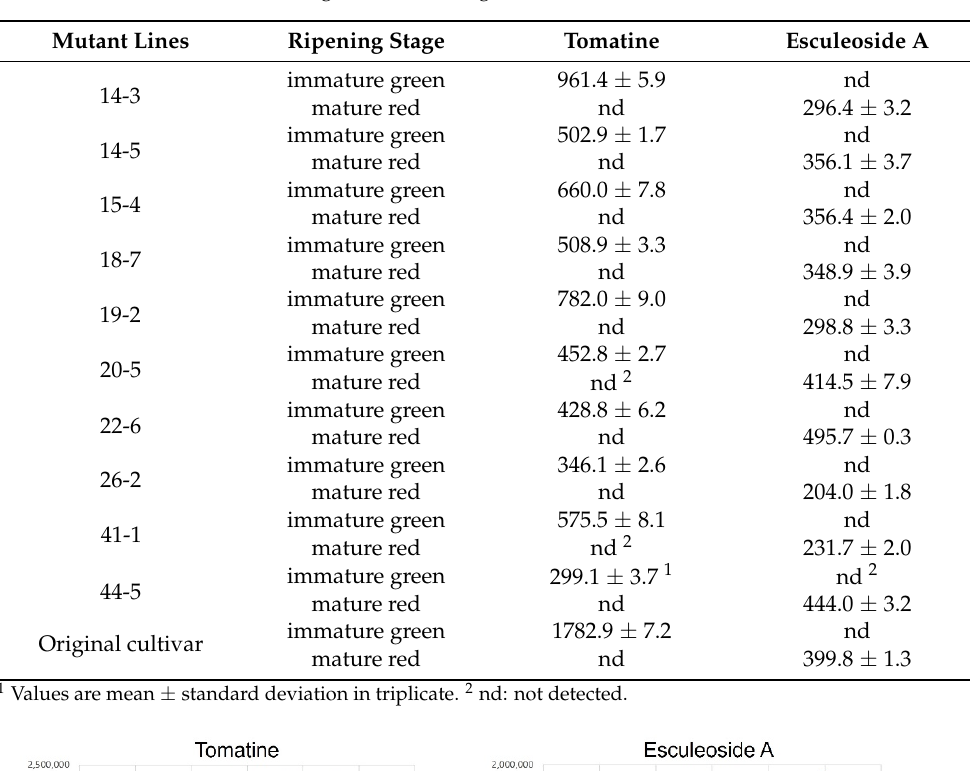
Table 1. Content of two triterpenoid glycosides ( µ g/g of fresh weight) in the top 10 mutant lines with low tomatine content among the immature green fruits of the mutant tomato lines.